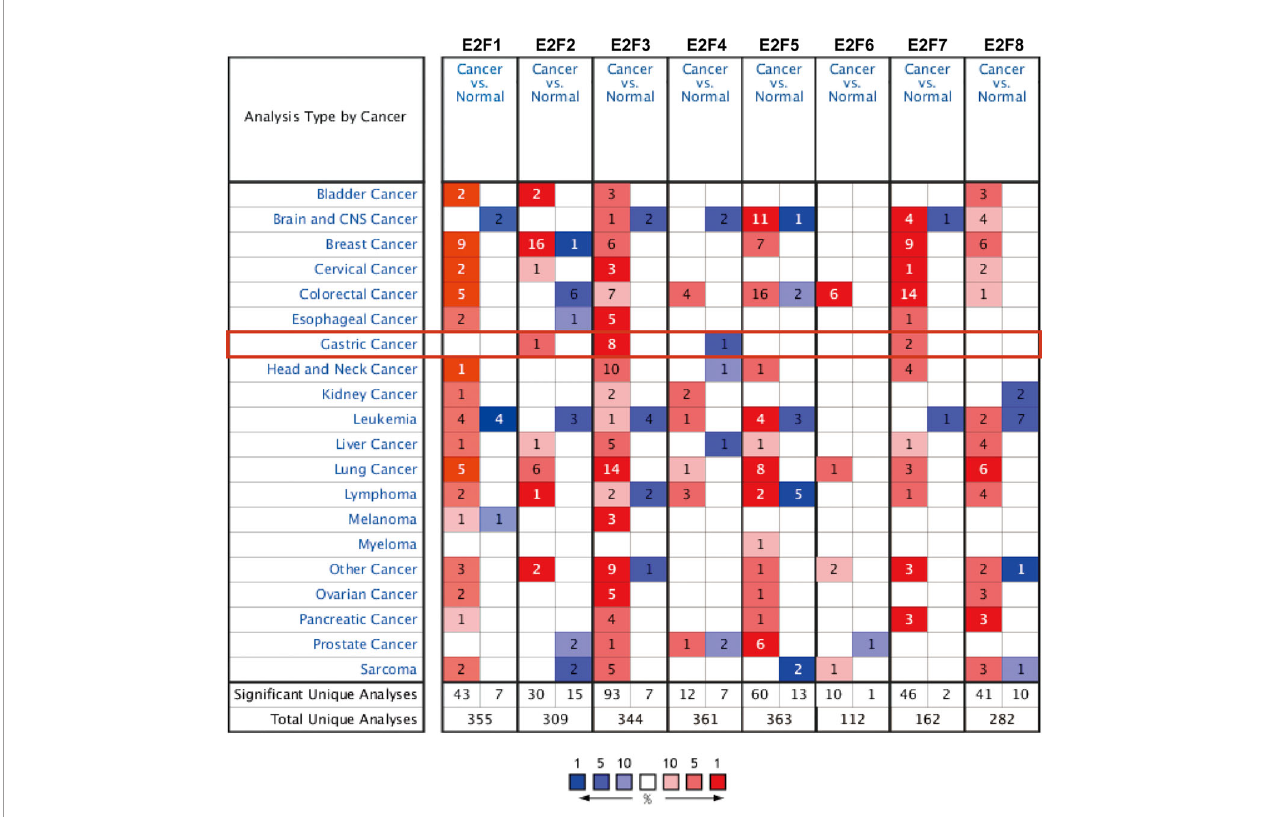
FIGURE 1 | The mRNA expression levels of E2Fs in 20 different types of cancer diseases (ONCOMINE). Differences in the mRNA levels were compared by student ’ s t -test. The parameters were set as follows: p = 0.01, fold change = 1.5, gene rank = 10%, and data type = mRNA. Multiple testing correction was conducted using the false discovery rate (FDR) method.